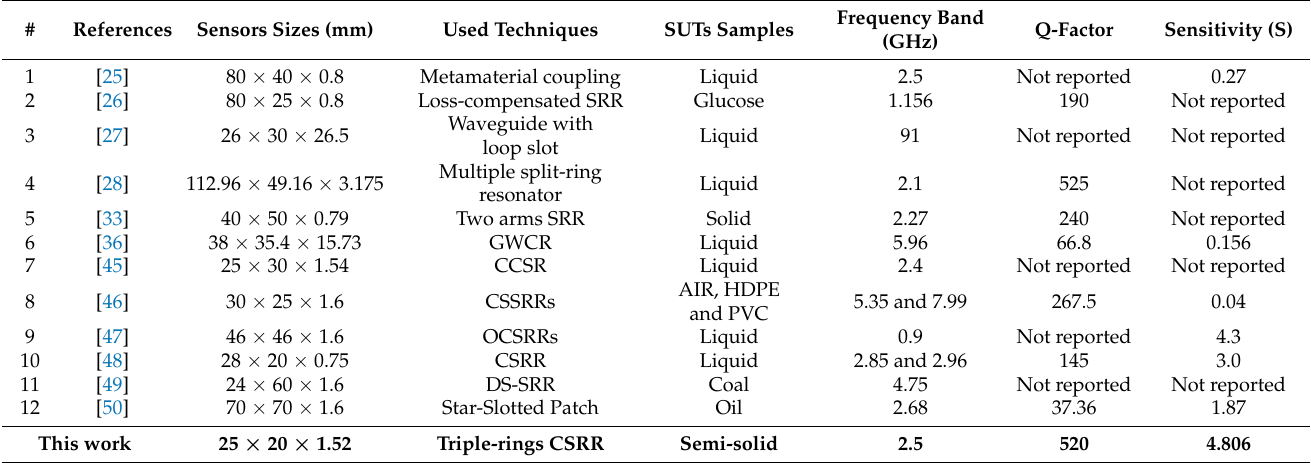
Table 11. Detailed comparison of state-of-the-art technology of curve-feed CSRR sensor for material detections with the existing work of